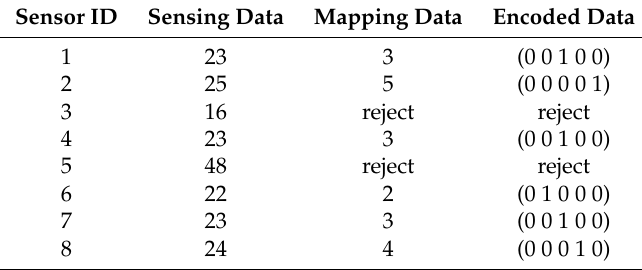
Table 4. Details of the values at each step in the